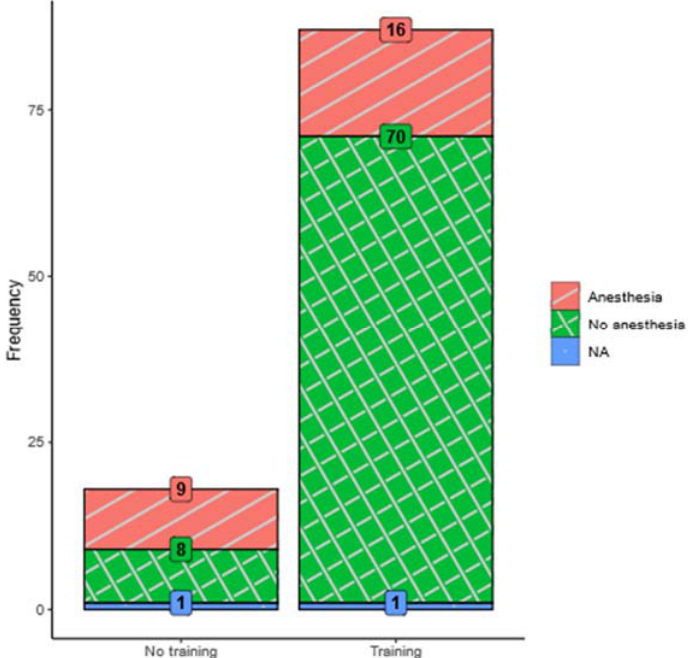
Figure 2. Stacked barplot for MRI success rates in both the intervention and the non ‐ intervention